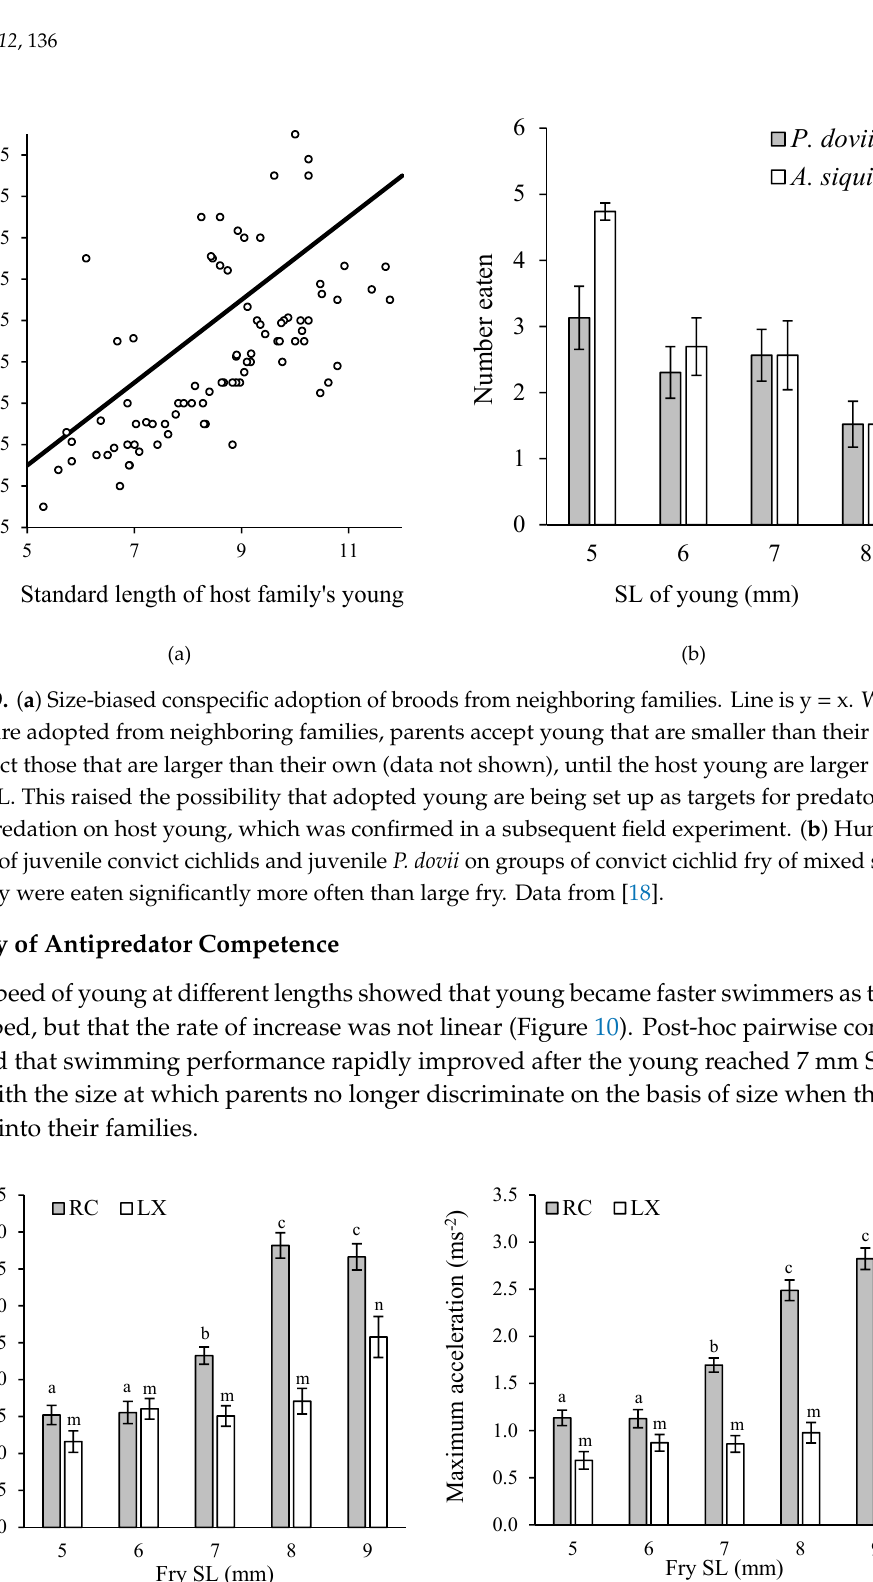
(b) Figure 11. ( a ) Cleared and stained larvae and juveniles with alcian blue (cartilage) and alizarin red (bone) for Río Cabuyo fish sized 5–9 mm SL. ( b ) Each specimen was imaged at high magnification so